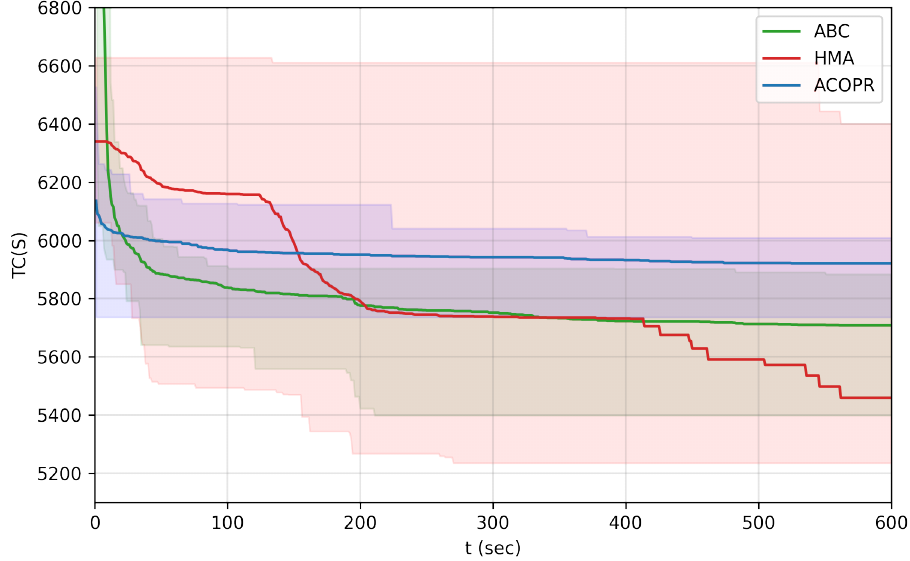
Figure 9. The convergence speed of 30 independent runs of HMA, ACOPR, and ABC algorithm on the “egl-s1-A” instance, plotted on one chart with time limit ( t ≤ 600 s).